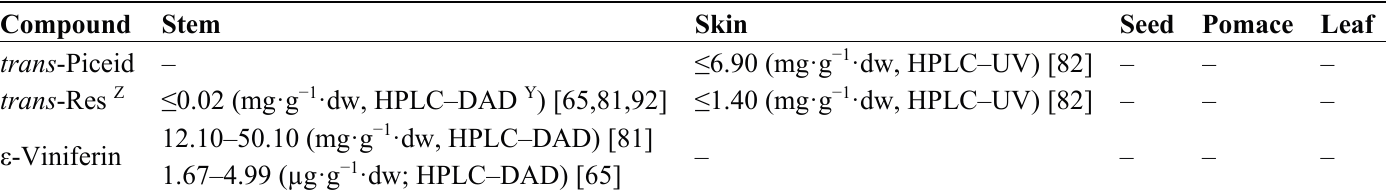
Table 7. Content in stilbenes (analytical technique employed) in winery residues of white grapes ( Vitis vinifera